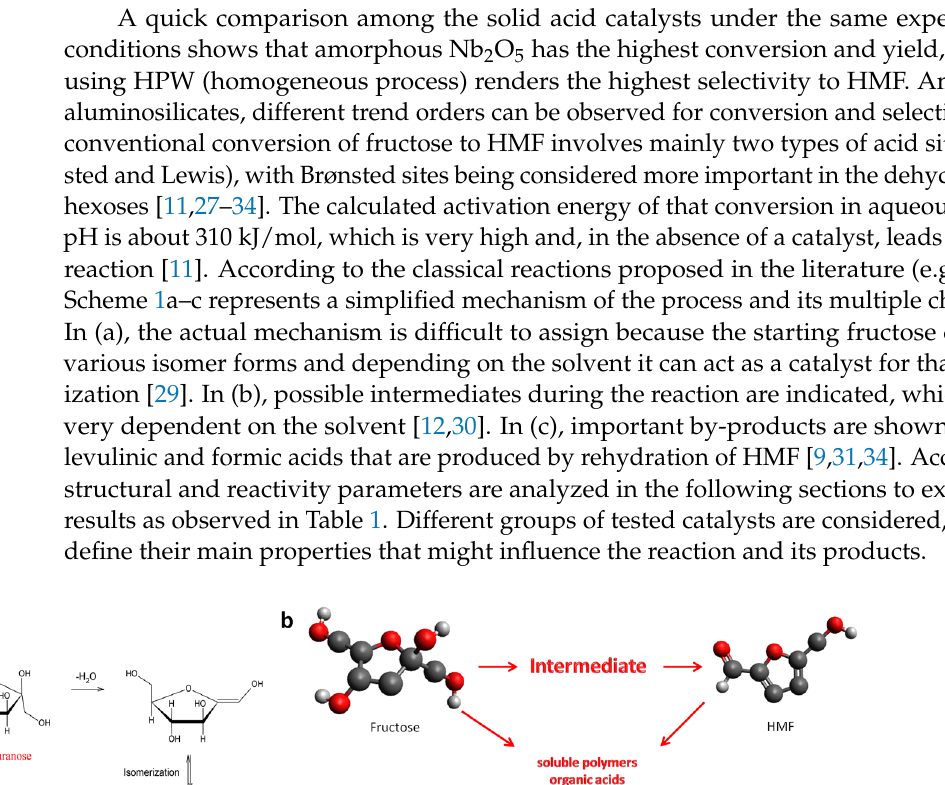
Figure 1. Typical contour map obtained for the HMF produced from the fructose dehydration reaction. ( a ) The left panel represents a standard solution of HMF (0.92 mg mL − 1 ), whereas ( b ) the right panel corresponds to a sample from the reaction with niobic acid.